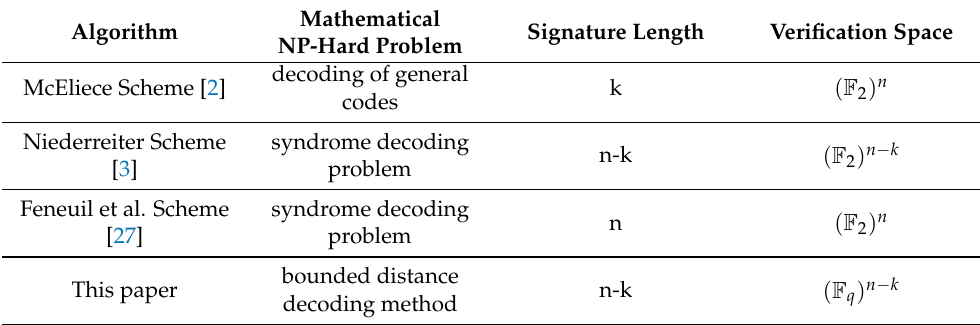
Table 2. Comparison with the other